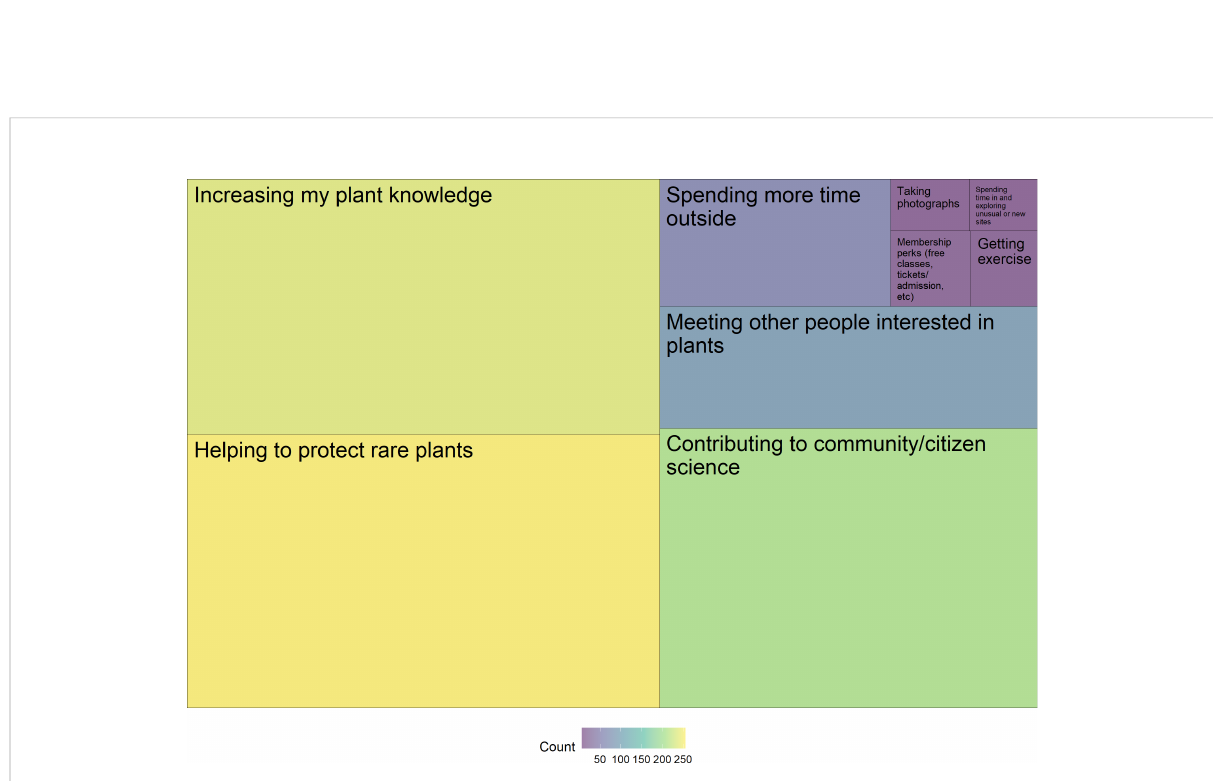
FIGURE 3 Participants ’ favorite aspect of participating in the project scaled by count. Color ramp by count from purple (least) to yellow (most). The most common favorite aspects were helping rare plants (75%), learning about plants (70%), and contributing to community science